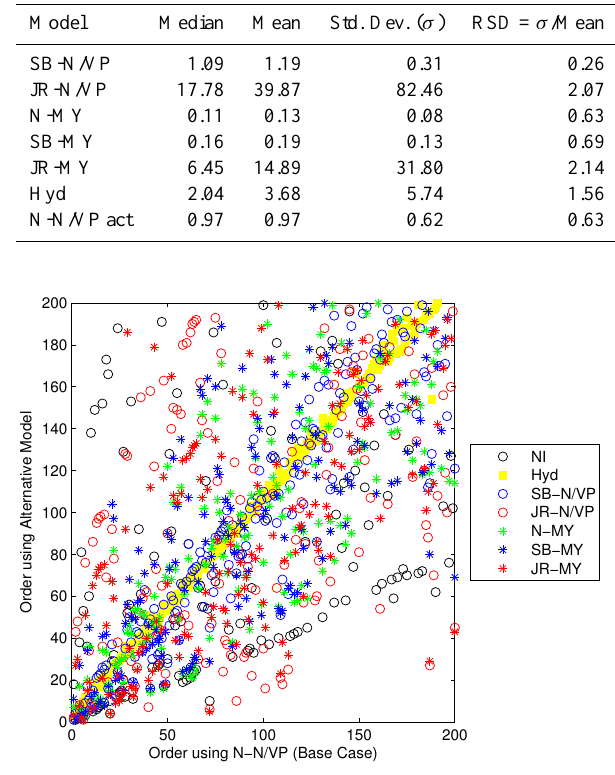
Fig. 3. Scatter plots showing the changes in the order of the top 200 compounds contributing to predicted SOA mass, compared to the base case (x-axis). SOA compositions used were from the stan- dard (1.0/1.0/1.0) scenario; with T = 293 . 15K, %RH = 70 and 3.0µgm − 3 involatile core. NI = N-N/VP